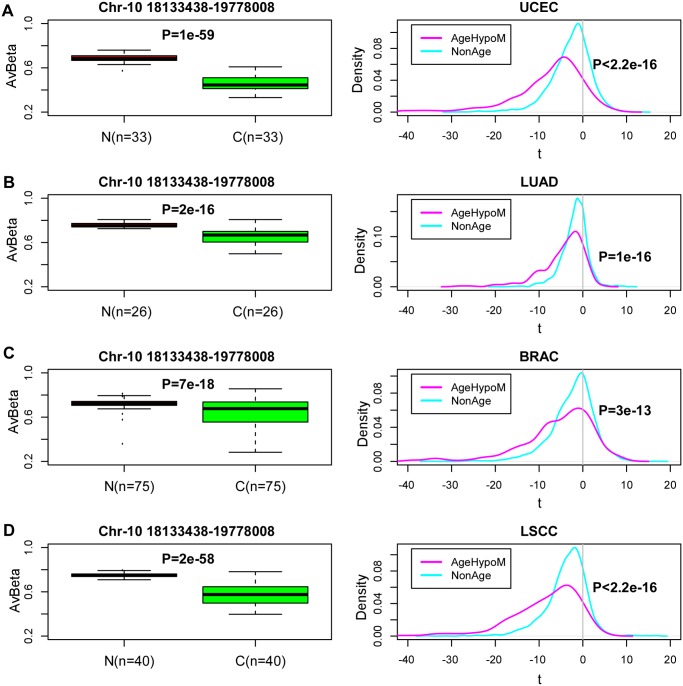
Age-associated hypomethylated blocks exhibit preferential hypomethylation in cancer.Left boxplots show the average beta methylation levels over open-sea regions within an age-associated hypomethylated block on Chr-10 in normal tissue and age-matched cancers from the TCGA. (A) Endometrial Cancer (UCEC), B) Lung Adenoma Carcinoma (LUAD), C) Breast Cancer, D) Lung Squamous Cell Carcinoma (LSCC). P-values in boxplots are from a Wilcoxon rank sum test. Number of samples in each group is indicated. Right panel depicts the density distribution of the t-statistics of all age-hypomethylated blocks (magenta), as assessed between normal and age-matched cancer tissue. The cyan curve represents the corresponding statistics for a random set of non-age associated blocks, matched for number and length distribution of the observed age-hypomethylated blocks. P-value is from a Kolmogorov-Smirnov test.